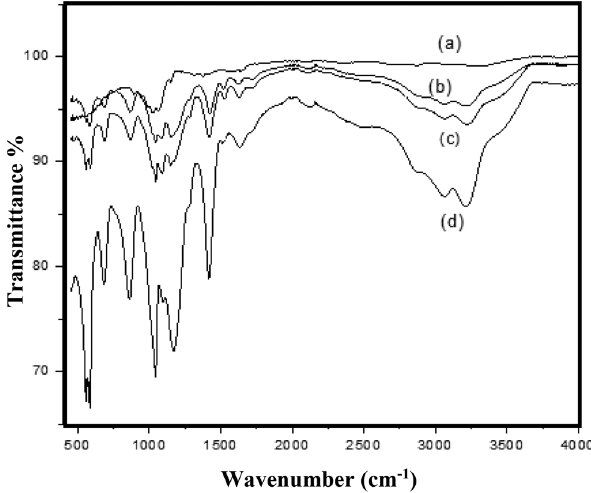
Figure 1: FTIR spectra of chitosan ( a ) , 1 g CH - g - POEA ( b ) , 0.5 g CH - g - POEA ( c ) , and pure polyorthoethylaniline ( d )